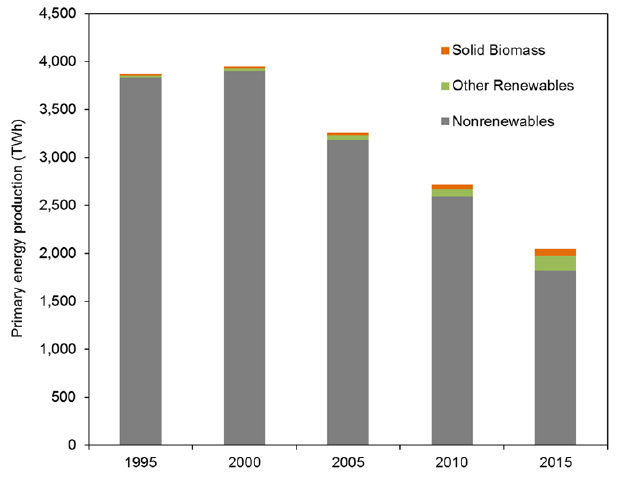
Fig. 5. Primary energy generation from solid biomass relative to other renewable and nonrenewable fuel sources used in the UK, the Netherlands, and Belgium (European Commission 2017 b